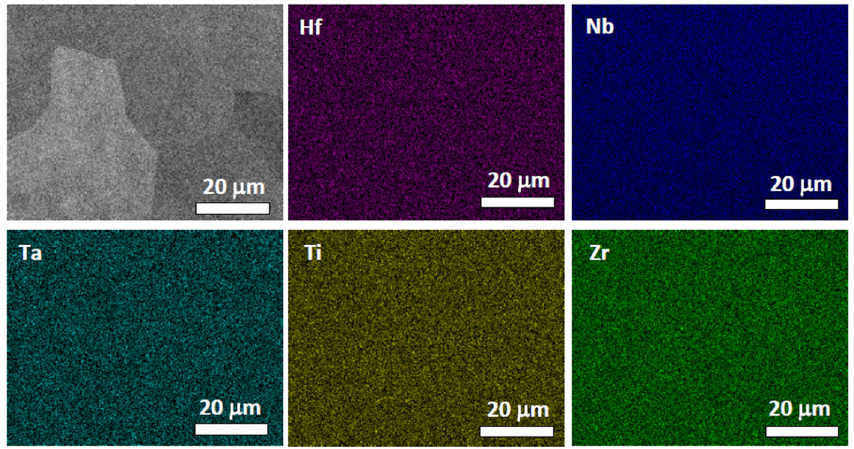
Figure 10. EDS elemental maps of HfNbTaTiZr alloy annealed at 1200 °C (SEM micrograph in the upper left panel indicates the inspected region).